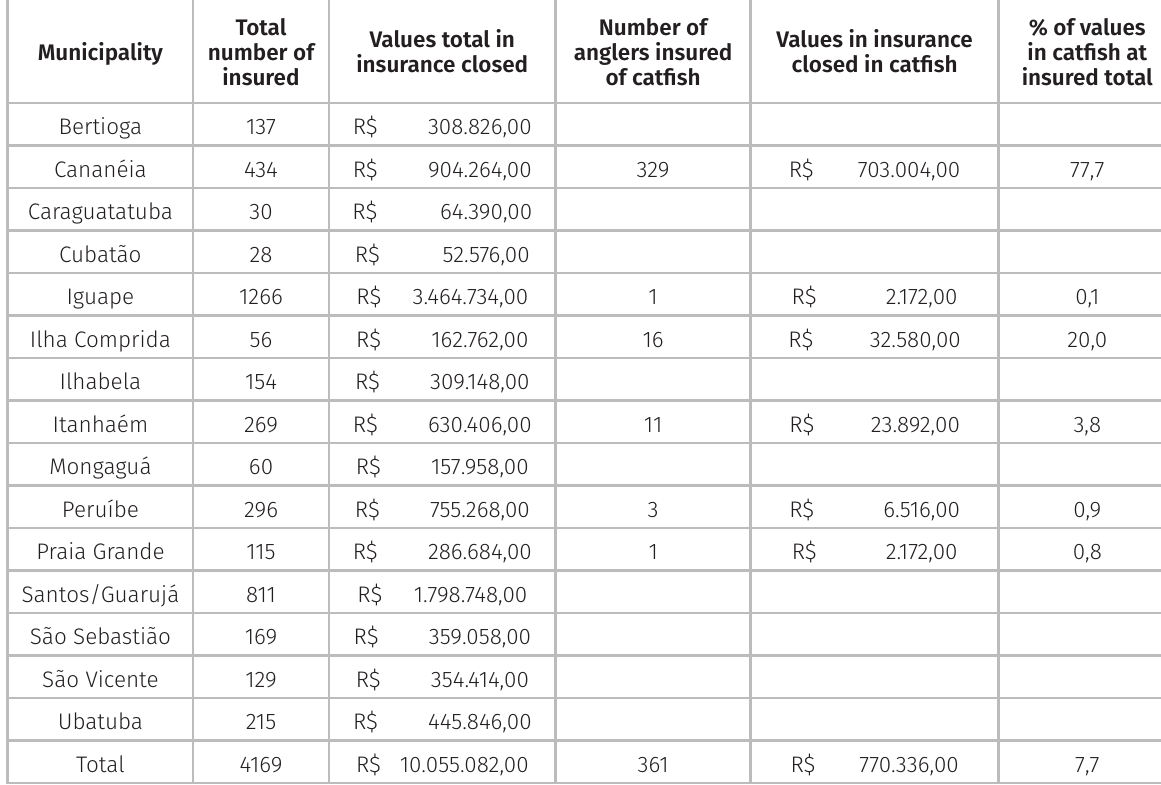
Table II. Costs of insured persons and total numbers of insured persons in the State of São Paulo in 2014 discriminated by municipality and the contribution of closed marine catfish fishery. Municipality